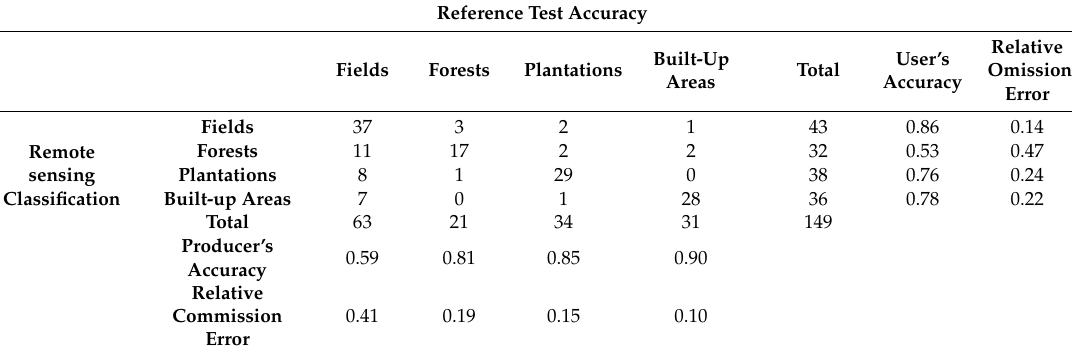
Table 1. Confusion matrix including user’s accuracy, relative omission error, producer’s accuracy and relative commission